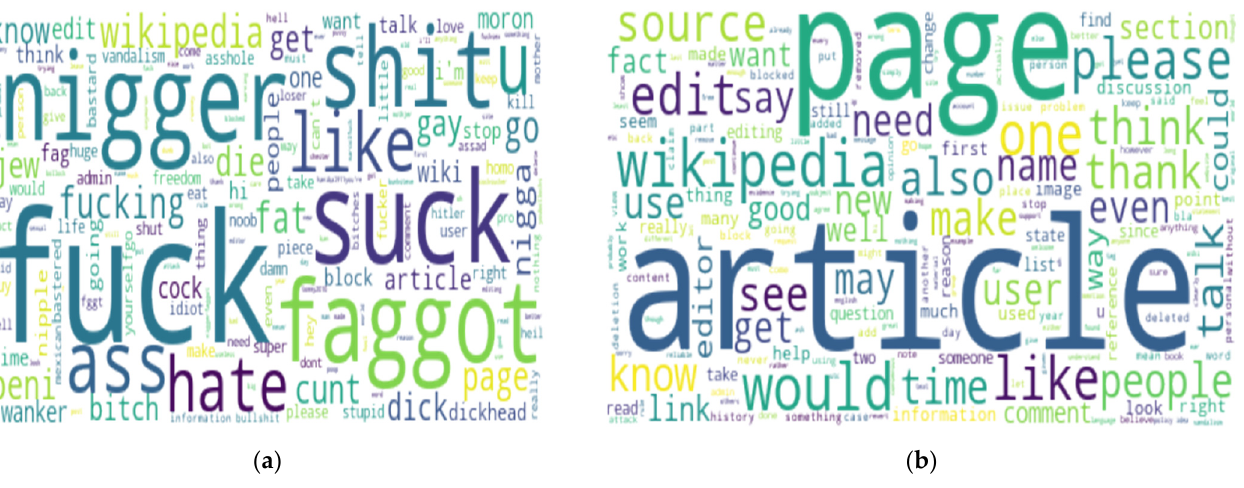
Figure 13. Word cloud for the binary class dataset ( a ) aggressive and ( b ) non-aggressive and cyberbullying.